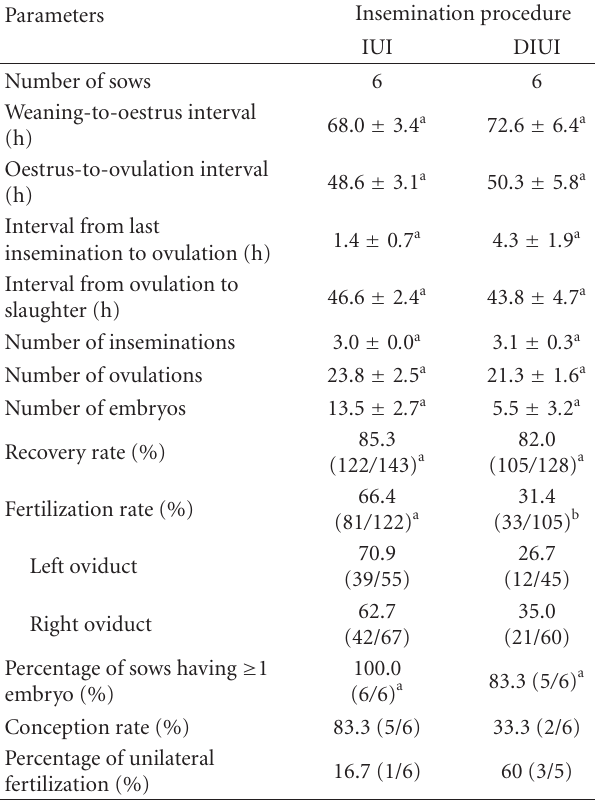
Table 1: Means ± standard error of the mean (SEM) of weaning- to-oestrus interval, oestrus-to-ovulation interval, interval from last insemination to ovulation, interval from ovulation to slaughter, number of inseminations, number of ovulations, recovery rate, fertilization rate, percentage of sows having ≥ 1 embryo, conception rate and percentage of unilateral fertilization after intrauterine (IUI) and deep intra-uterine insemination (DIUI) using frozen- thawed boar semen in multiparous sows.